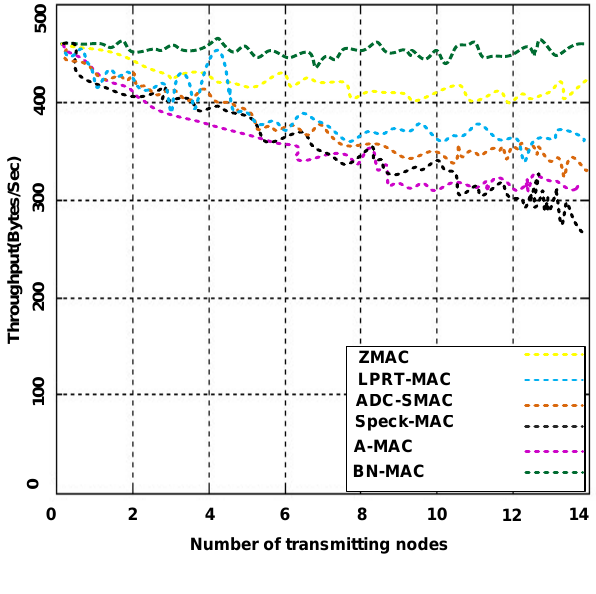
Figure 11. Throughput under heavy traffic using a low duty